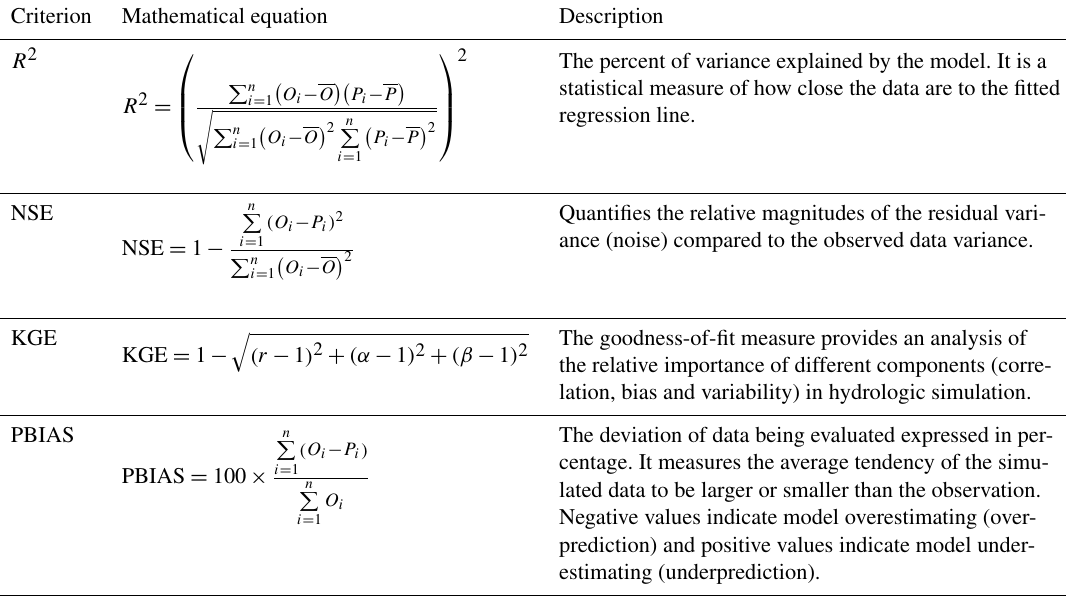
Table A1. Table showing the performance metrics and their equations used to evaluate the model performance in this study. Criterion Mathematical equation Description The percent of variance explained by the model. It is a statistical measure of how close the data are to the fitted regression